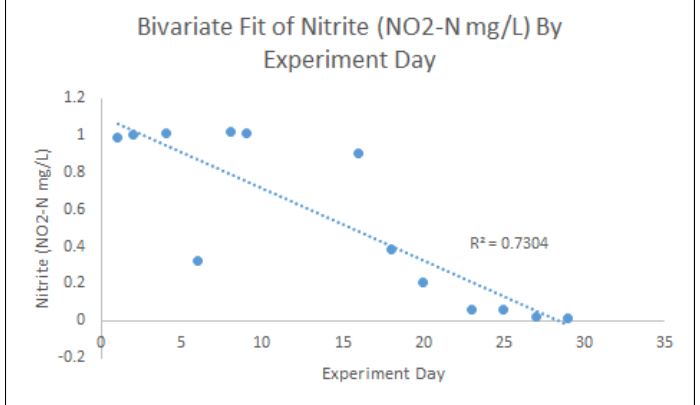
Figure 4. The correlation of nitrite to time shown in